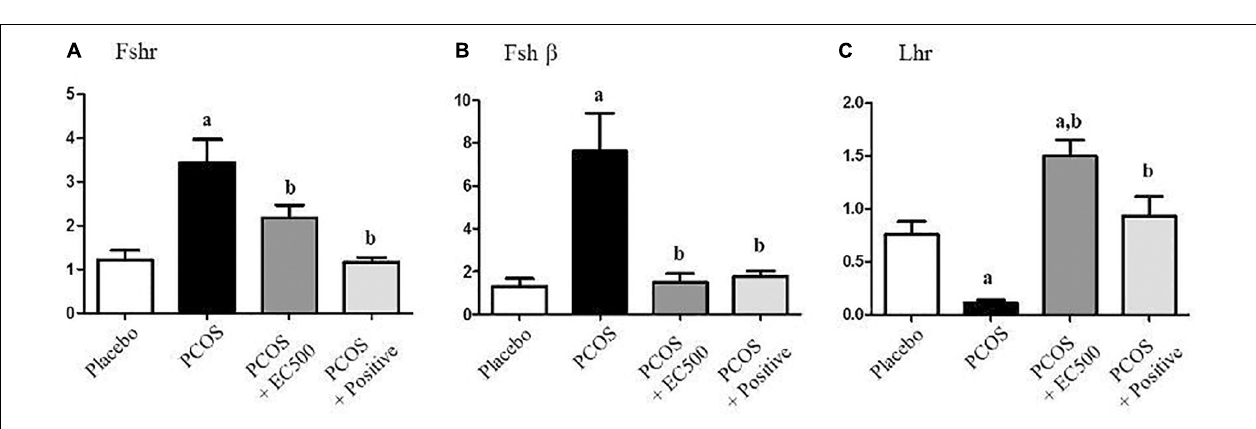
FIGURE 5 | Effects of E. cava extract on gonadotropin-related genes. For PCOS experiments, 6-week-old female rats were administered letrozole pellets (0.1 mg/kg/day). After 2 weeks, E. cava extract was administered via P.O. treatment every day for 2 weeks. (A) Fshr , (B) Fsh β , and (C) Lhr mRNA levels were determined by quantitative RT-PCR. Gapdh mRNA was used as an internal control. Values represent the means ± SEM. a p < 0.05 vs. placebo group, b p < 0.05 vs. PCOS group. EC, E. cava extract; PCOS, polycystic ovary